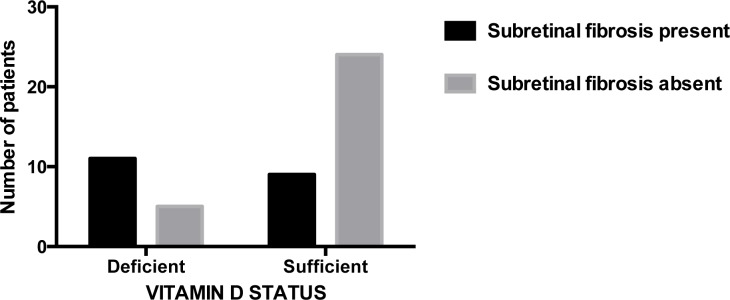
Subretinal fibrosis status in patients with vitamin D insufficiency or sufficiency.Patients without subretinal fibrosis (light filling) were more likely to be vitamin D sufficient compared to those with subretinal fibrosis (dark filling) who were more likely to be deficient (p = 0.006, Pearson's Chi-square test). Vitamin D insufficiency was defined as 25-hydroxyvitamin D≤50 nmol/L and sufficiency was defined as >50 nmol/L.